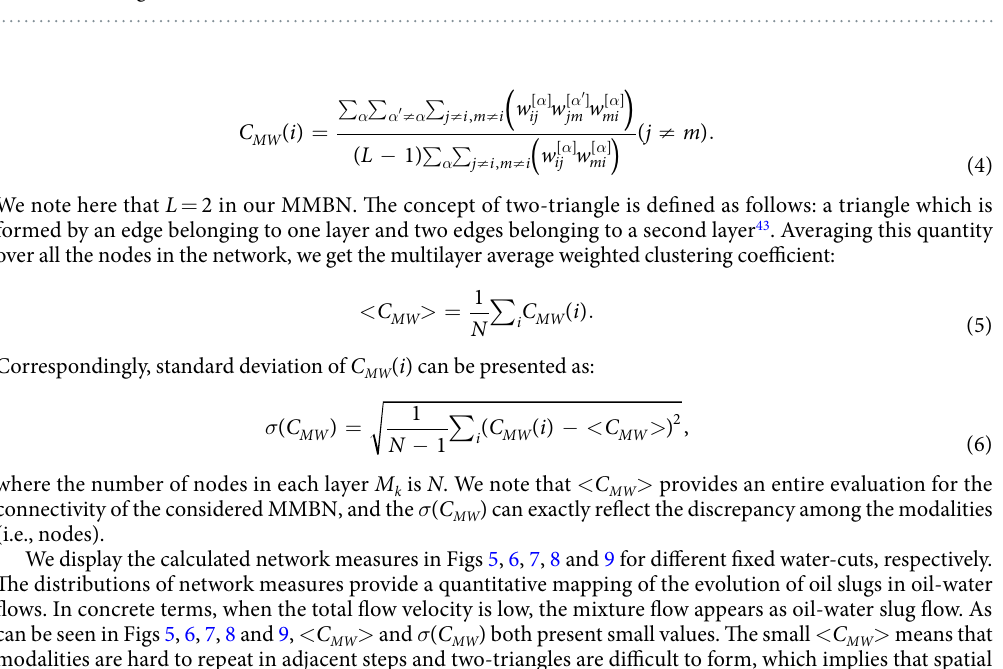
Figure 4. Boxplots of the standard deviation of the part PageRank versatility distribution series (part PRVDS) for oil-water slug flow and bubble